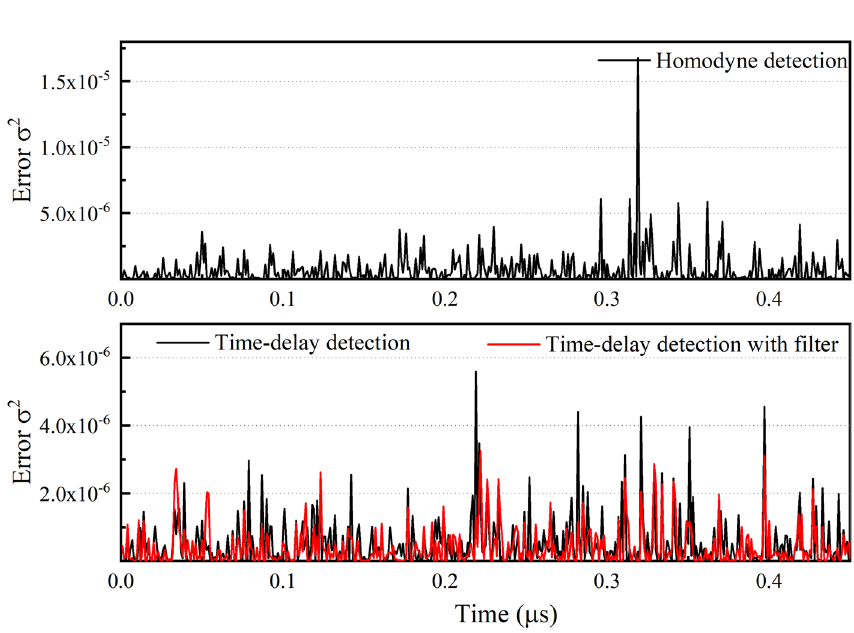
Figure 6. Comparison chart for results of classical direct structure measurement, delay structure measurement, and delay structure measurement with additional